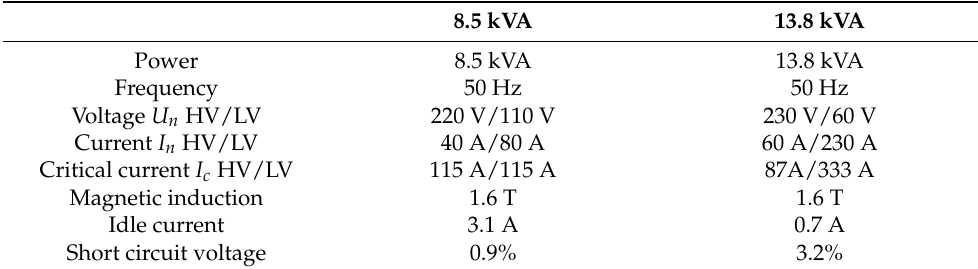
Figure 9. 8.5 kVA superconducting transformer construction, 1—cryostat, 2—primary winding HV, 3—connecting terminals, 4—primary winding carcass, 5—secondary winding carcass, 6—secondary winding LV. Table 1. Parameters of 8.5 kVA and 13.8 kVA HTS